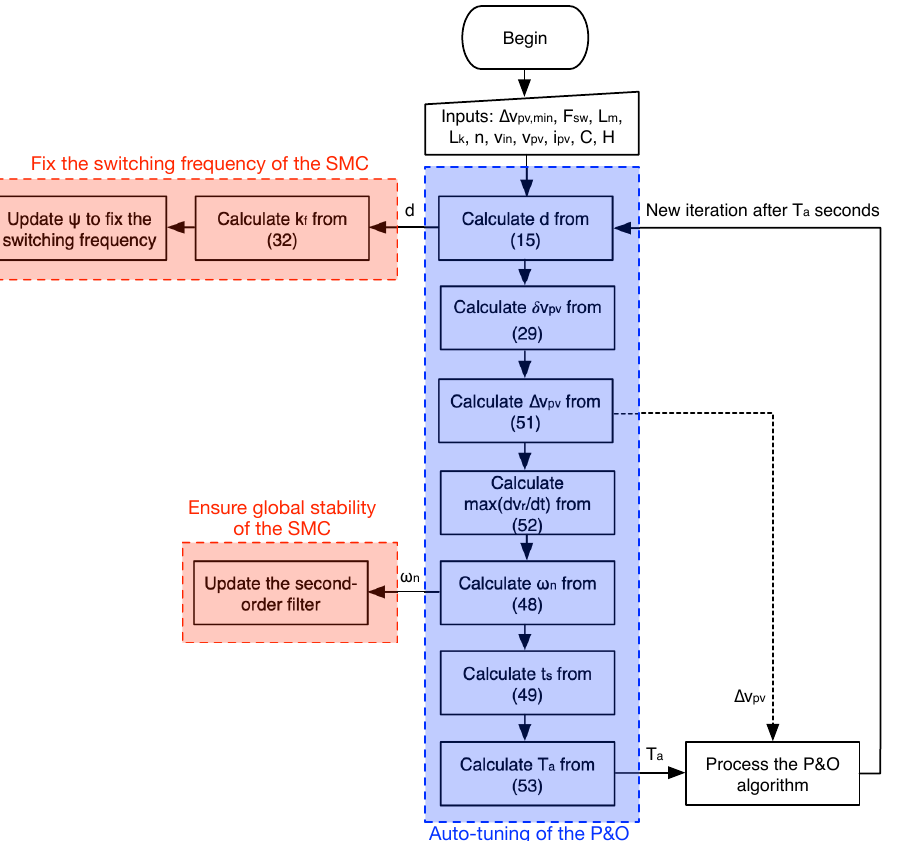
Figure 8. Calculation process for the P&O parameters, k f gain and adaptive